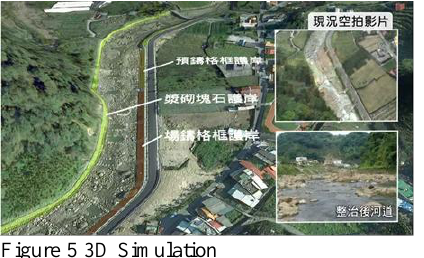
Figure 5 3D Simulation